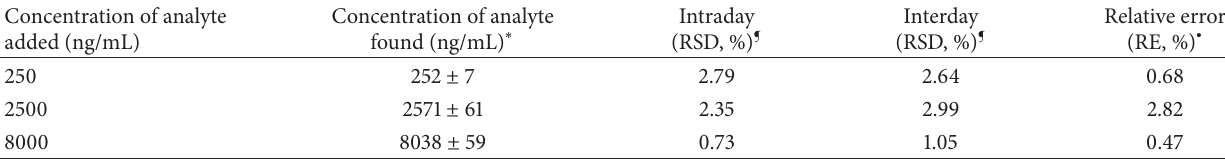
Table 1: Intraday and interday precision and accuracy data for FLC assay in C. albicans matrix.